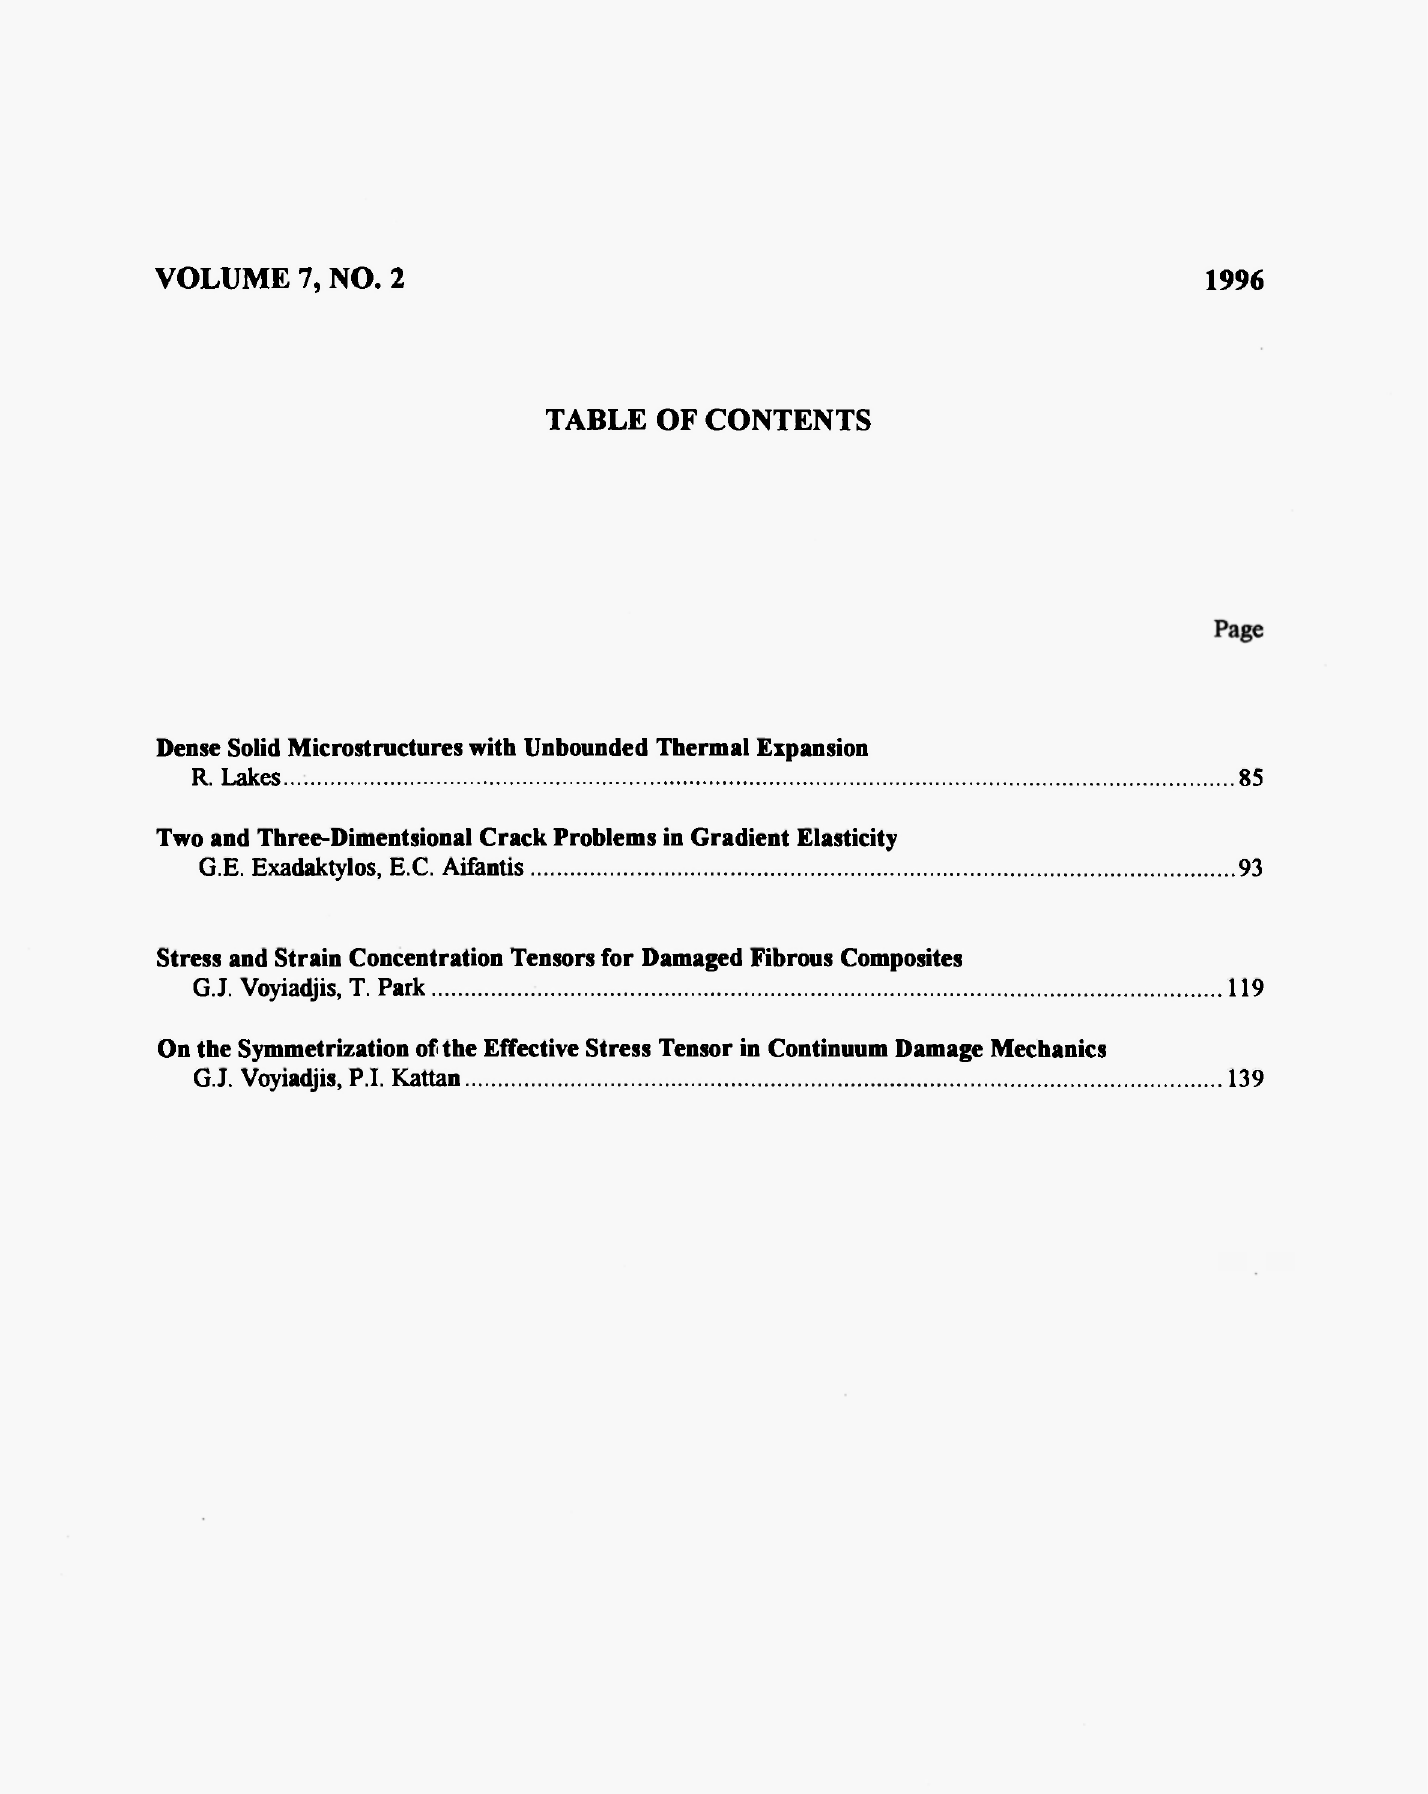
On the Symmetrization of the Effective Stress Tensor in Continuum Damage